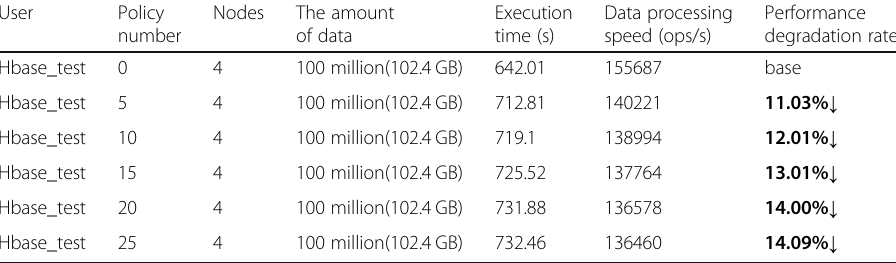
Table 4 Test results of different number of security policies based on the User-Resource-Rights